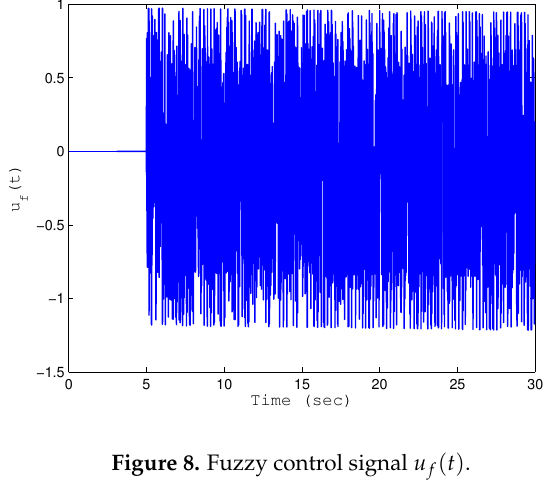
Figure 8. Fuzzy control signal u f ( t ) .